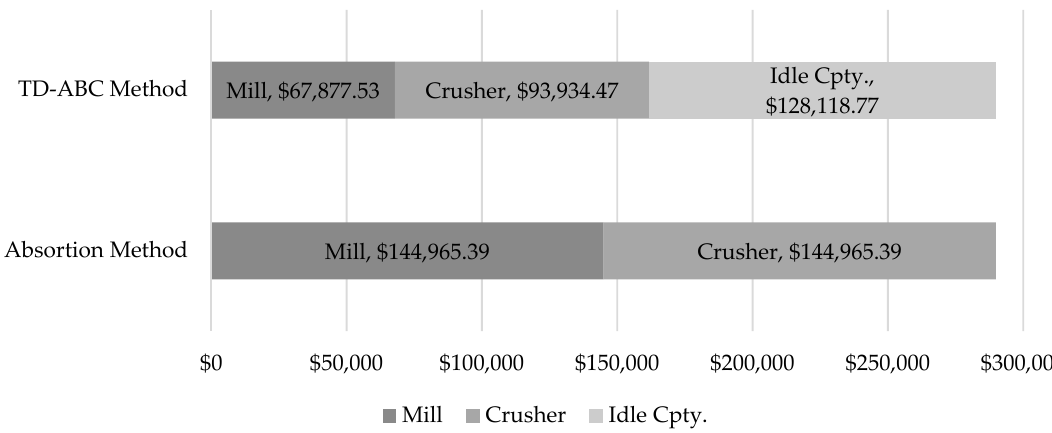
Figure 5. Comparison between traditional (absorption) and TDABC costing.